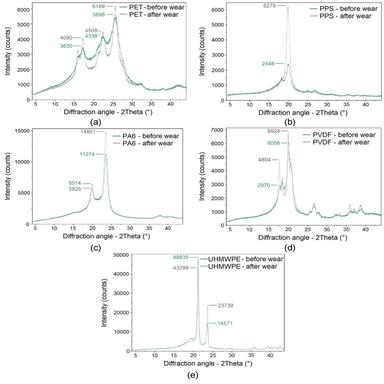
XRD curves of PET (a), PPS (b), PA6 (c), PVDF (d) and UHMWPE (e).